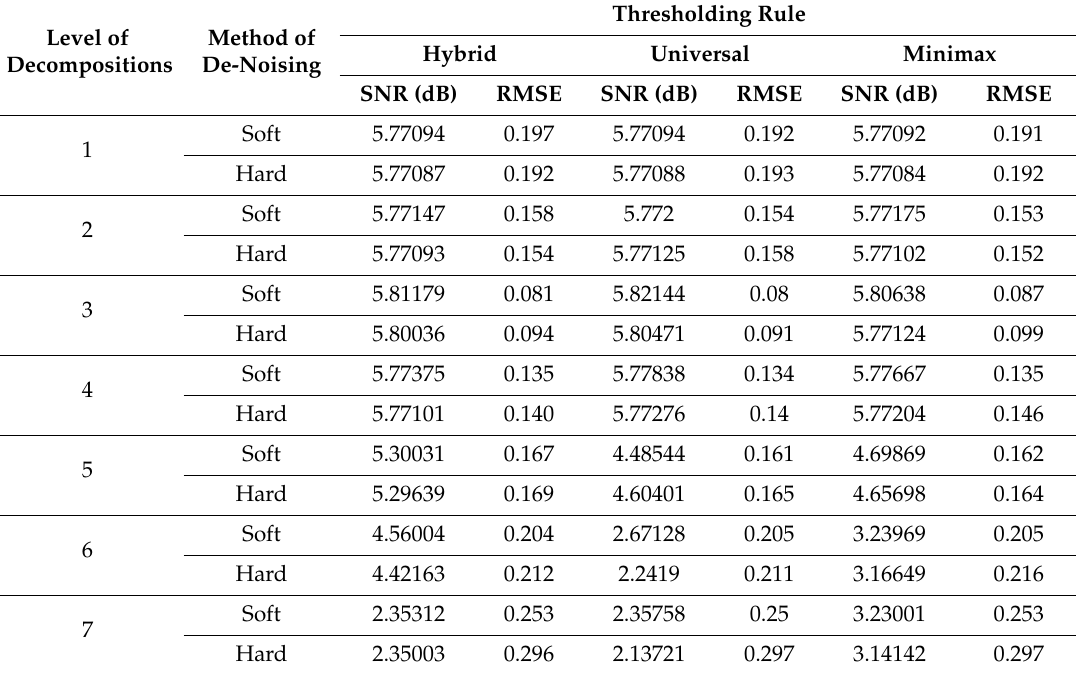
Table 3. E ff ect of decomposition level and de-noising on the SNR and RMSE of the sensor signal. Level of